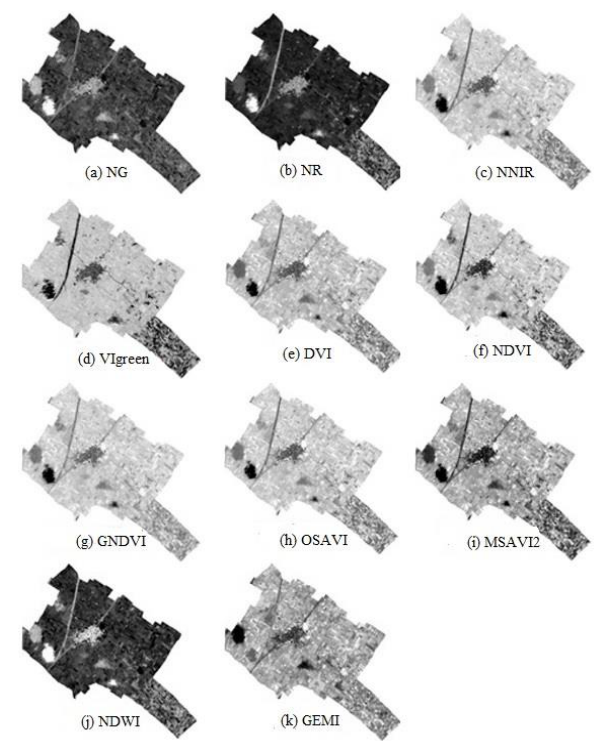
Image is a function f(x,y) of two space variables x and y, x=0,1,…..,N-1 and y=0,1,……, M-1. The function f(x,y) can take discrete values i=0,1,…..,G-1, where G is the total number